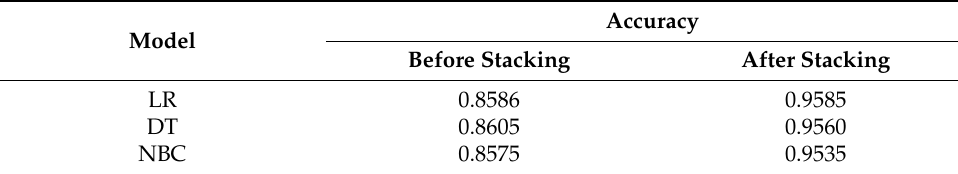
Table 5. Accuracy after stacking for three